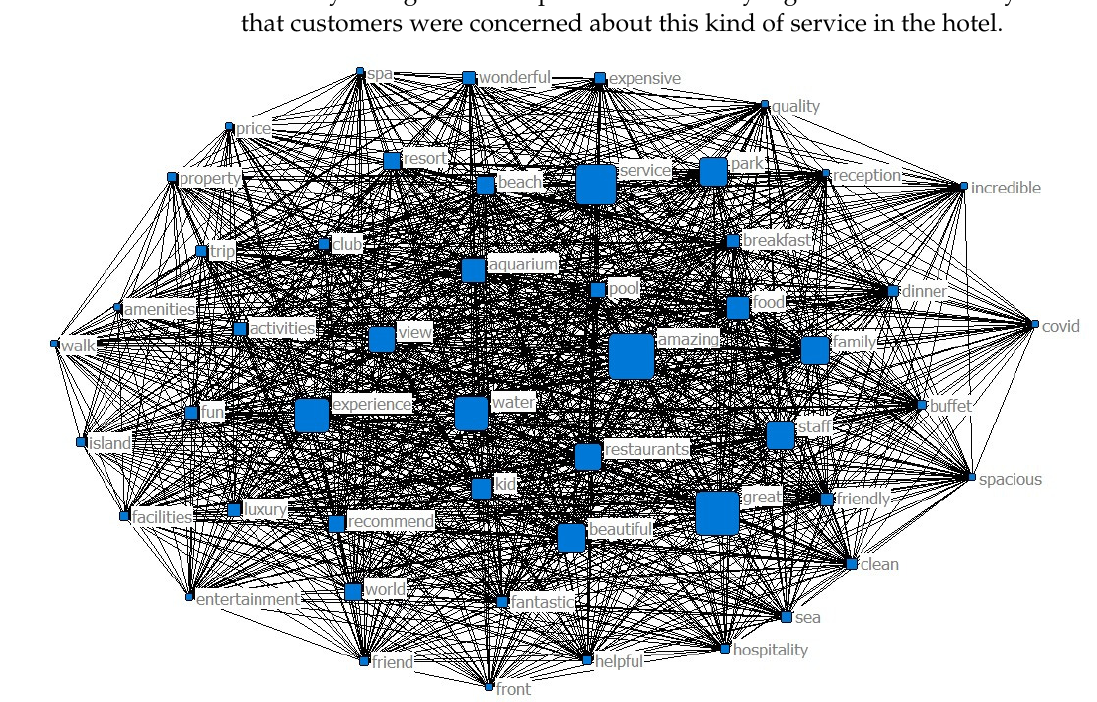
Figure 2. Atlantis, The Palm—keywords visualization of network analysis. Table 2. Comparison of keyword frequency and centrality